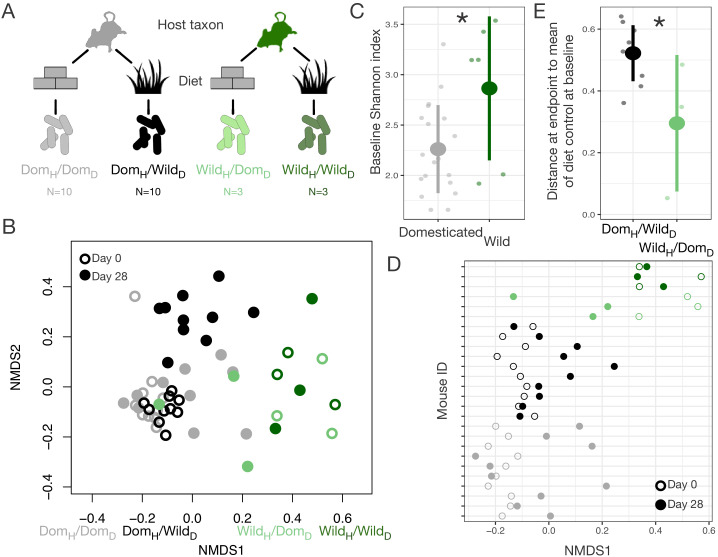
Gut microbial differences between wild and domesticated mice can be partially overcome by diet swap.(A) Design scheme for fully factorial host taxon by diet mouse experiment (N = 10 laboratory mice or three wild mice per diet group). (B) Nonmetric multidimensional scaling (NMDS) ordination of Bray–Curtis dissimilarities showing changes for mice from day 0 (open circle) to day 28 (filled circle) by experimental groups (color). Composition varied by host taxon (p<0.001, R2 = 0.173, F = 64.255, permutational MANOVA), diet (p<0.001, R2 = 0.042, F = 15.427), and a host taxon by diet interaction (p<0.001, R2 = 0.020, F = 7.557). (C) Shannon index differed between host taxa on day 0 (p=0.011, Mann–Whitney U test). (D) Animals on reciprocal diets (DomH/WildD and WildH/DomD) but not control diets tended to move in opposite directions along Bray–Curtis ordination NMDS axis 1 from day 0 to day 28 (p=0.048 and p=0.25, respectively, one-sample Wilcoxon test). (E) At the end of the experiment, distance to the mean of the diet control at baseline (DomH/DomD and WildH/WildD) was lower for wild mice than for laboratory mice (p=0.048, Mann–Whitney U test). * indicates p<0.05, Mann–Whitney U test. Large circles are means; bars show standard deviations.